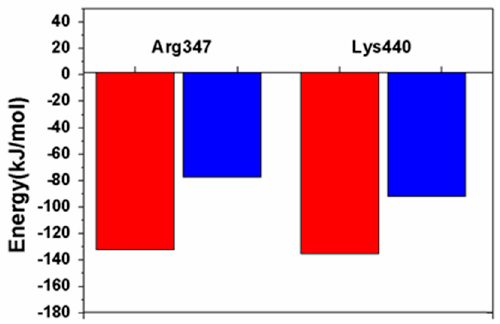
Figure 7. Binding energy contributions of Arg347 and Lys440.